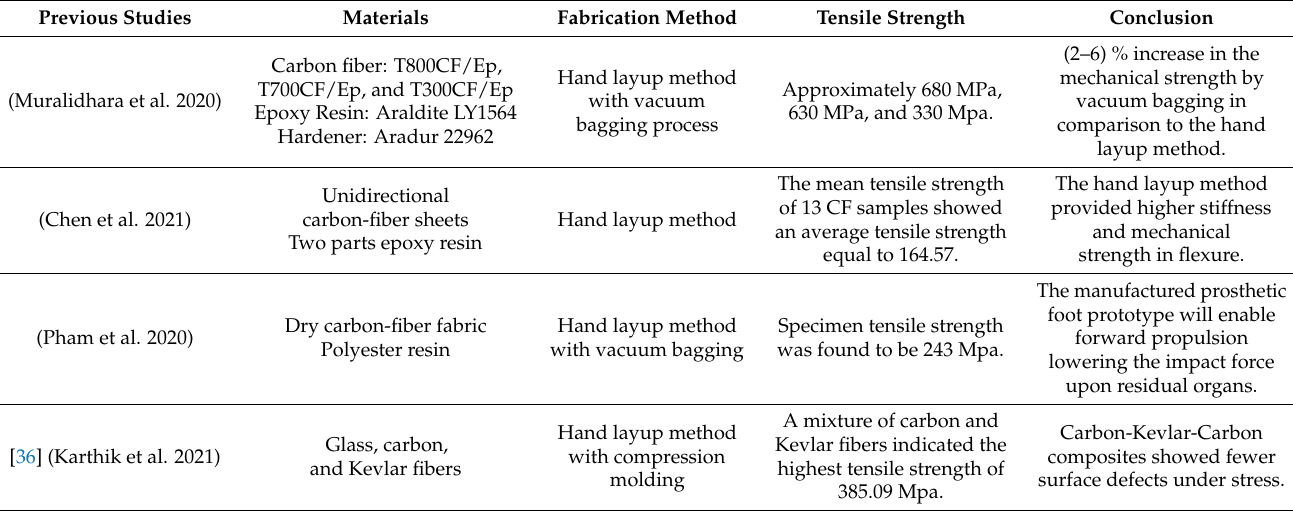
Table 5. Comparison of Findings of Previous